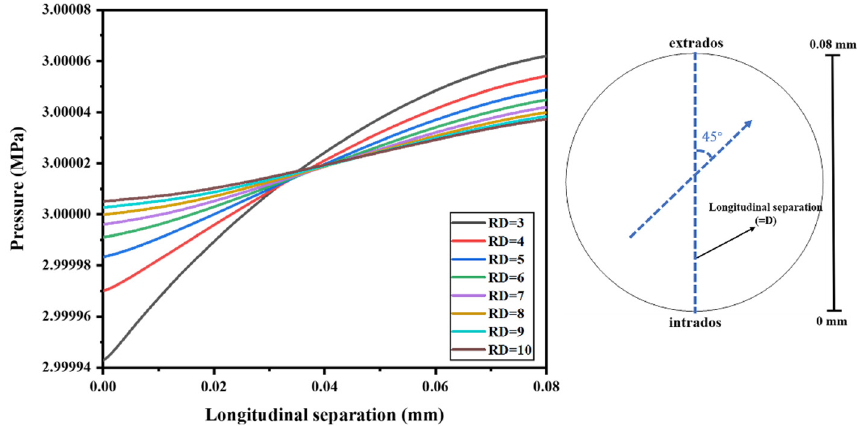
Figure 16. Pressure gradient variation in section longitudinal direction at 45 of elbow with different curvature ratios.